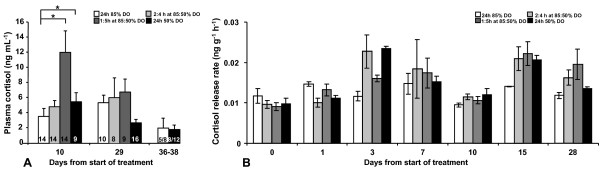
Plasma cortisol and cortisol release rate after fixed and cyclic, low DO levels at high temperature (Experiment 2). This experiment aimed at mimicking DO levels measured in sea cages in fjords sheltered from waves, wind and strong currents. In these situations, cyclic drops in DO levels are frequently observed during slack water at tidal reverse and further decreased DO levels are observed during high temperatures. Four oxygen treatment regimes were initiated: fixed 50% or 85% DO levels, or 50% or 85% DO levels in two different 6 hour cycles (4:2 h at 85:50%; 1:5 h at 85:50%) at 16°C. Blood was sampled for plasma cortisol measurements from all treatment groups day 10 and 29, and from the fixed 85% and 50% DO groups between days 36-38. Cortisol levels in plasma at different time points after start of Experiment 2, assessing the impact of cyclic and fixed DO levels. Plasma cortisol samples below the limit of detection was removed and indicated in each bar (A). DO levels were not affected by sampling occasion (p = 0.572) but slightly influenced by DO treatment levels (p = 0.088). An interaction was observed (p = 0.029) and Bonferroni corrected pair-wise comparison of plasma cortisol levels revealed elevated cortisol levels in the 1:5 h at 85:50% DO group and 50% DO group compared to the 85% DO group (p = 0.002 and p = 0.012 respectively) at the first sampling after 10 days. Thereafter no differences could be observed. Overall, the cortisol release rate (B) reflected the plasma cortisol levels as there was a tendency toward lower cortisol release rate in the 85% DO group (p = 0.1). Further, plasma cortisol levels on day 29 appeared to be reflected in the cortisol release rate on day 28. All data are expressed as means ± SEM and p < 0.05 was regarded as significant and indicated as *, p < 0.01 as ** and p < 0.001 indicated as ***.